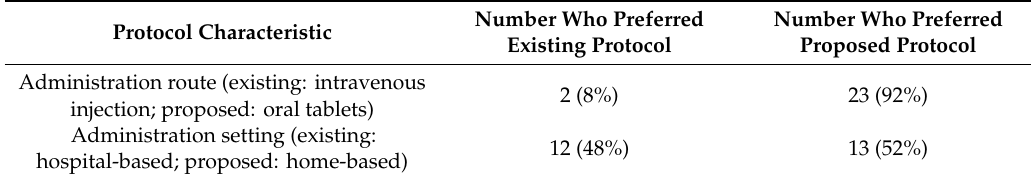
Table 2. Patient preferences for the administration route and setting of human African trypanosomiasis (HAT)